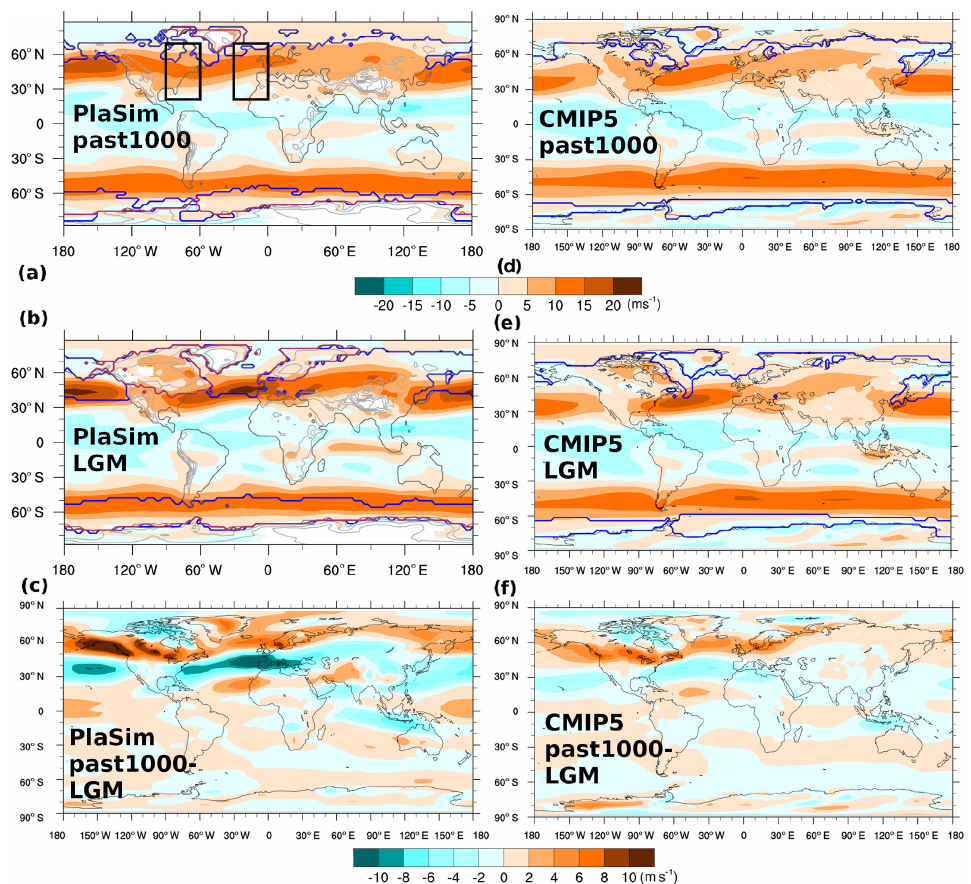
Figure 4. Zonal winds averaged over 700 to 925hPa and averaged over all PlaSim ensemble members or CMIP5 multi-model ensemble members for DJF and indicated periods. Where the land surface impinges on the vertical range, winds are interpolated to not bias the vertical average. Further discussion can be found in Sect. 4. Differences between climatologies for these two periods are in the bottom row. Blue lines mark the outline of the 15% concentration line for sea ice and purple lines mark the land-ice mask in PlaSim simulations. Black boxes outline the regions over which the western and eastern components of the NAtl jet are